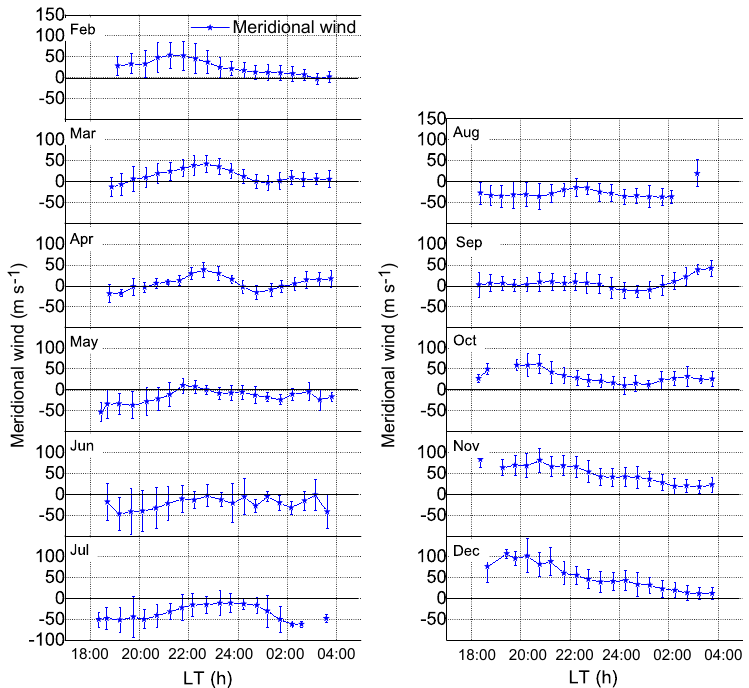
Figure 4. Monthly average of the meridional component of thermospheric neutral wind. Positive values are northward. LT is UT −